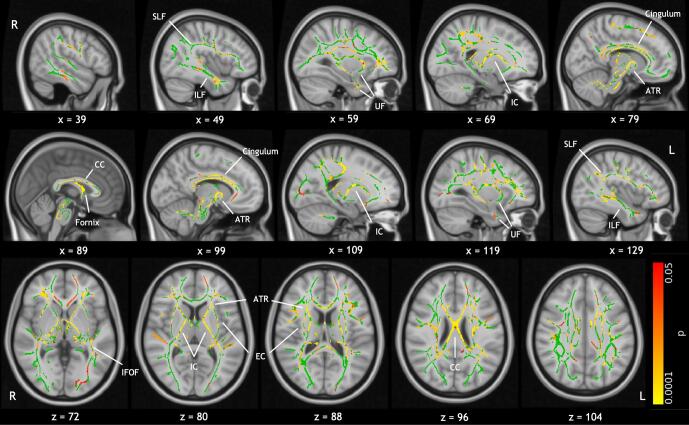
Results of voxelwise comparison of FA on the white matter skeleton (green) with TBSS. Areas of significantly reduced FA in cases are indicated by the colour bar (p < 0.05, TFCE corrected), and include the fornix, corpus callosum, anterior and posterior limbs of the internal capsule bilaterally, and the cingulum bilaterally. These are overlaid on the MNI standard template. Labels indicate some major white matter tracts and regions. Abbreviations are as follows: anterior thalamic radiation (ATR), corpus callosum (CC), external capsule (EC), internal capsule (IC), inferior fronto-occipital fasciculus (IFOF), inferior longitudinal fasciculus (ILF), superior longitudinal fasciculus (SLF), uncinate fasciculus (UF). (For interpretation of the references to colour in this figure legend, the reader is referred to the web version of this article.)